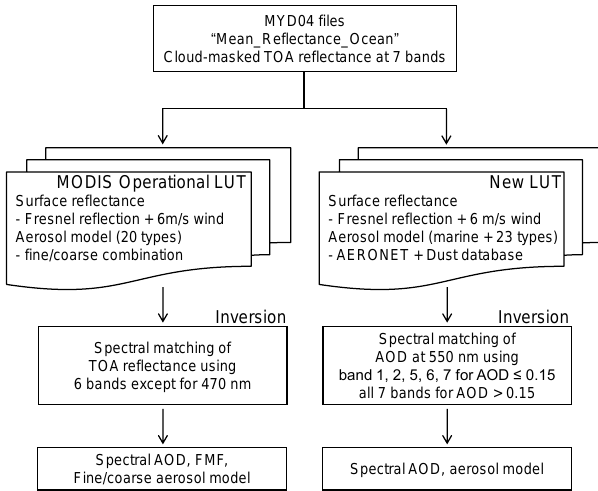
Fig. 1. Schematic flowchart of aerosol retrieval by the MODIS C005 algorithm (left column) and the test algorithm (right column). The test algorithm was designed to use the same observation data (“Mean Reflectance Ocean” in “MYD04” files) as the C005 algo- rithm to evaluate the effects of the new aerosol models only. The major difference between the two algorithms is the aerosol models used to calculate the